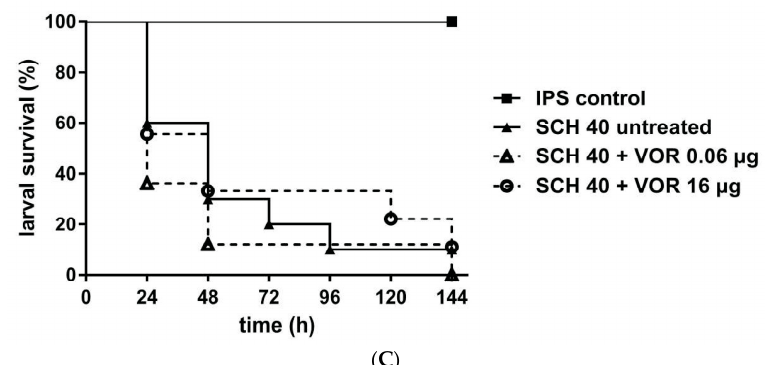
Figure 2. Survival rates of G. mellonella larvae infected with C. albicans and receiving voriconazole (VOR) treatment. Three different C. albicans isolates SCH 24 ( A ), SCH 36 ( B ), or SCH 40 ( C ) were tested, all exhibiting persisting growth with VOR up to 16 µ/mL. Larvae were infected with 10 6 cells of the respective isolates and received antifungal treatment with 0.06 µg/larva or 16 µg/larva VOR, 2h post infection. Insect physiological saline (IPS) was used as an injection control and larvae receiving no antifungal treatment served as control. For detailed information about strains susceptibility profiles see Table 1. Survival curves represent the average survival of all larvae ( n = 40) tested.